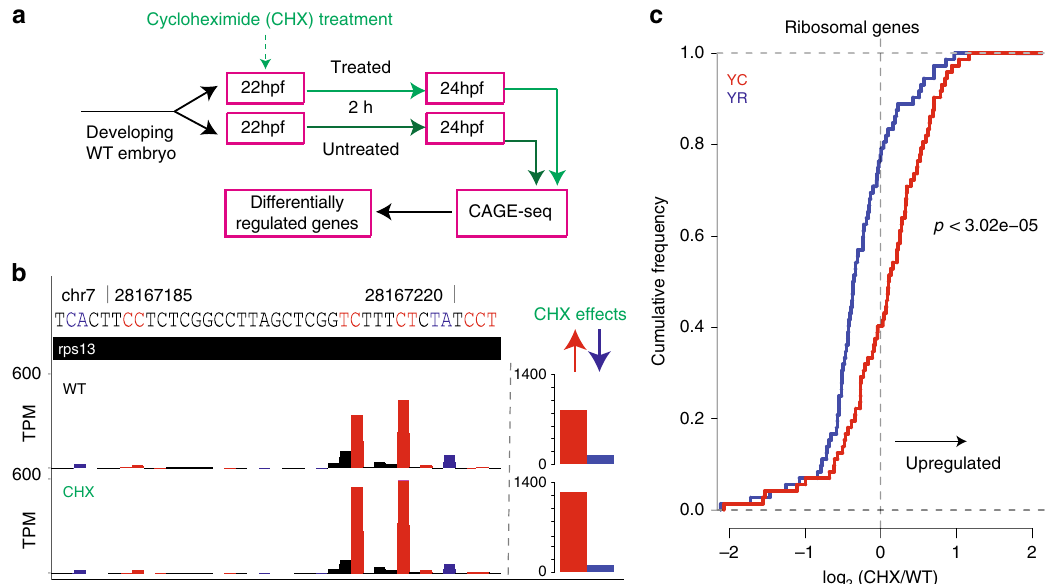
Fig. 6 Differential regulation of YR-initiation and YC-initiation during translation inhibition. a Experimental design to study the response of YC-initiation and YR-initiation products during translation inhibition by cycloheximide. b A UCSC browser screenshot showing an example of levels of YR and YC components of the dual-initiation promoter gene rps13 . The bar chart includes sum of all peaks. c Cumulative frequency of YR-initiation and YC-initiation of all ribosomal protein genes after cycloheximide treatment. X -axis indicates the log 2 fold change of YR-initiation and YC-initiation in cycloheximide and wild type